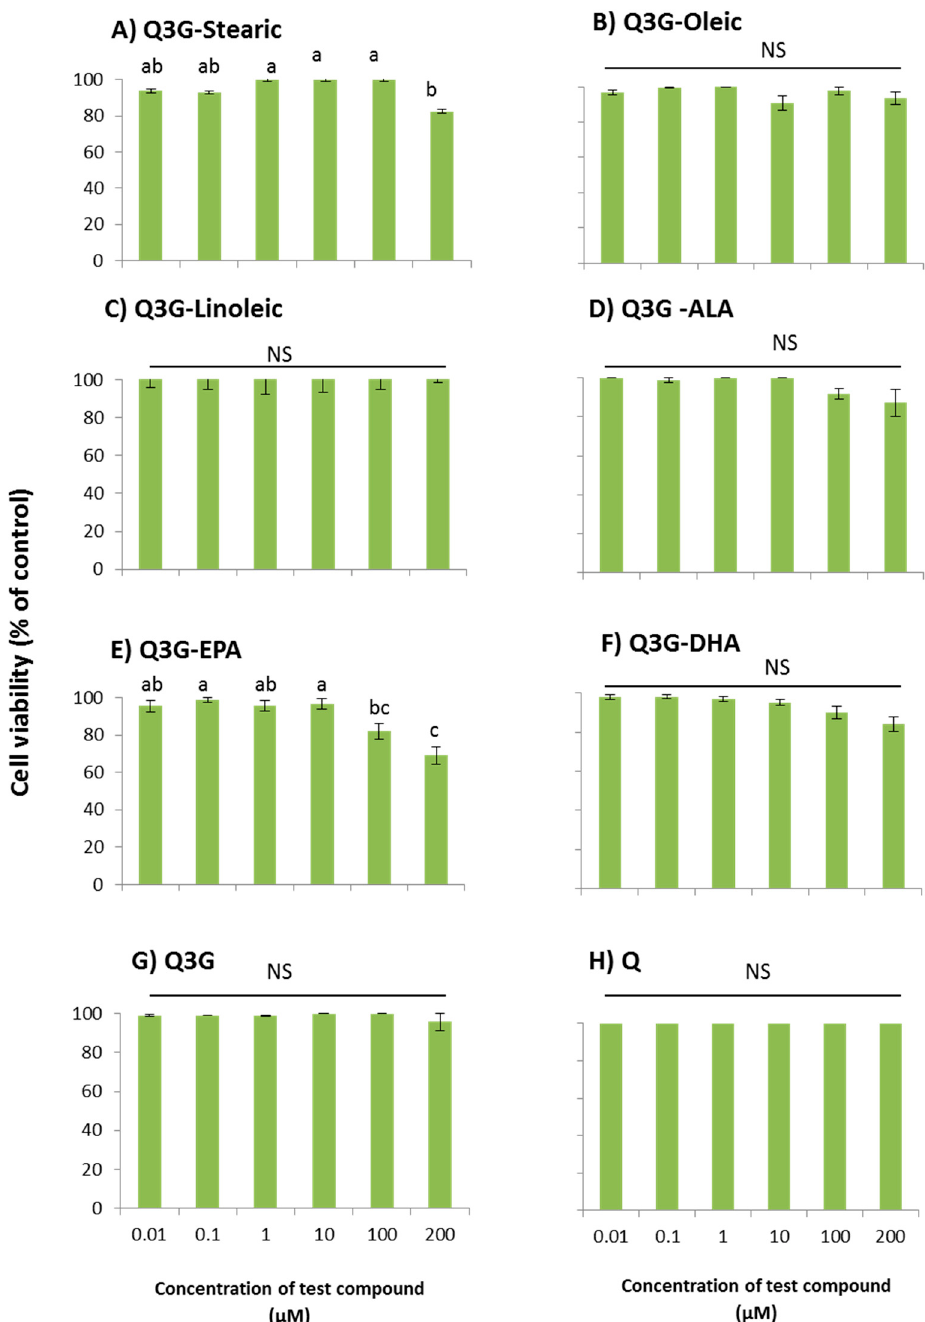
Figure 4. Dose-dependent cytotoxicity of fatty acid esters of Q3G in WI-38 cells; ( A ) Stearic acid ester of Q3G; ( B ) Oleic acid ester of Q3G; ( C ) Linoleic acid ester of Q3G; ( D ) ALA ester of Q3G; ( E ) EPA ester of Q3G; ( F ) DHA ester of Q3G; ( G ) Q3G and ( H ) Quercetin. Cells were pre-incubated with test compounds for 48 h. Cell viability was presented as percentage related to the control. Control contains cells with no incubation of test compounds. Data are expressed as mean ± SEM ( n = 6), means sharing